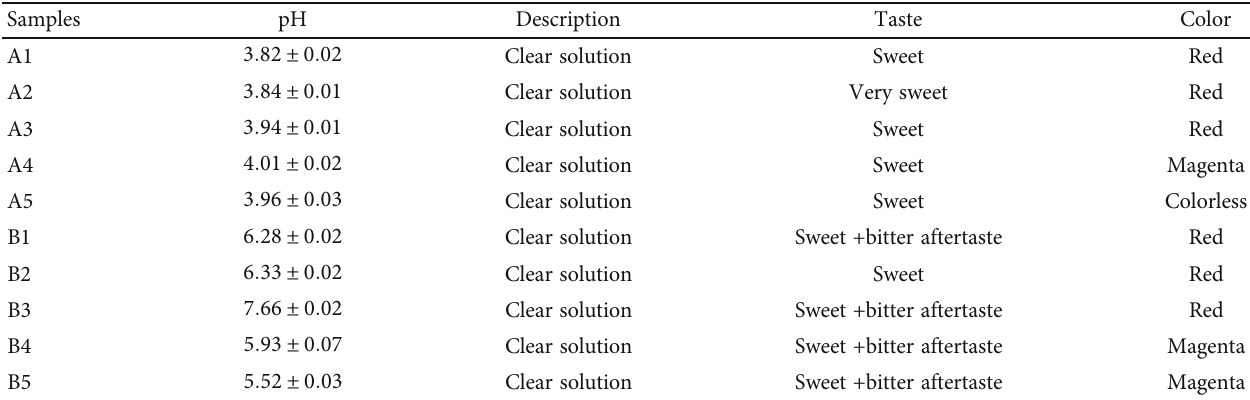
Table 4: Organoleptic properties and pH of